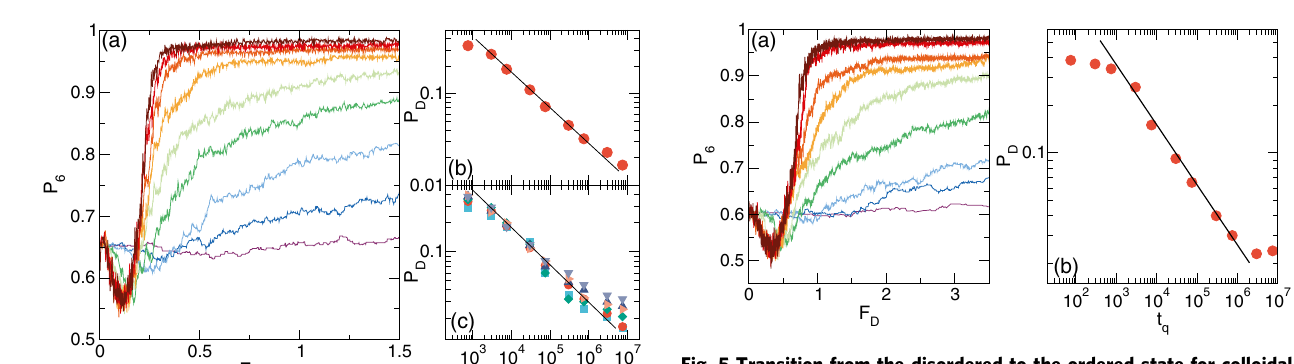
COMMUNICATIONS PHYSICS| (2022) 5:173